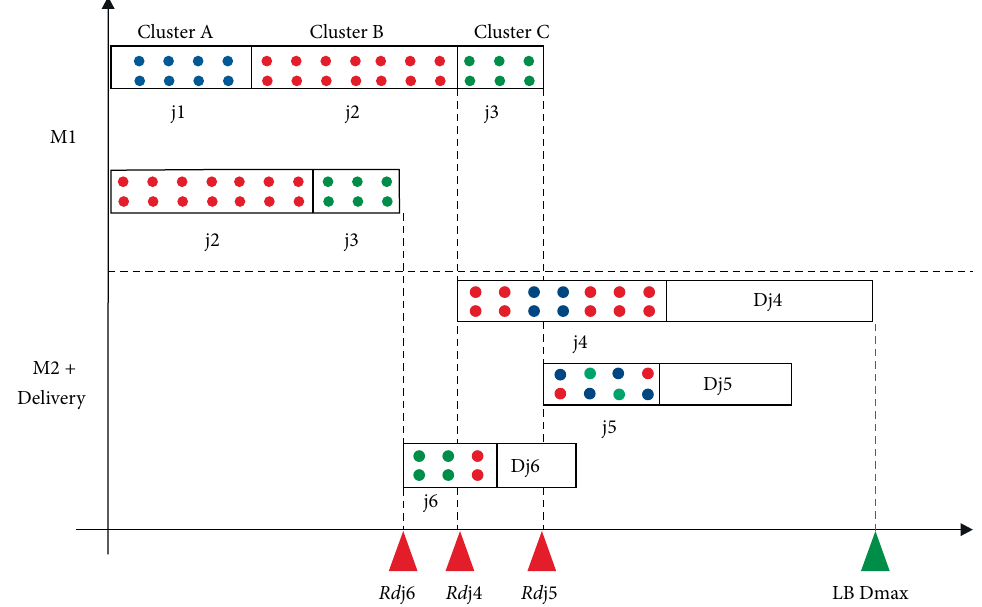
Figure 4: A lower bound solution example. The red triangles represent the release dates for each job. Furthermore, the green triangle represents the LB value. The figure depicts how the minimum release date ( 𝑅𝑑 ) is computed for each 𝑗 ∈ 𝐽 2